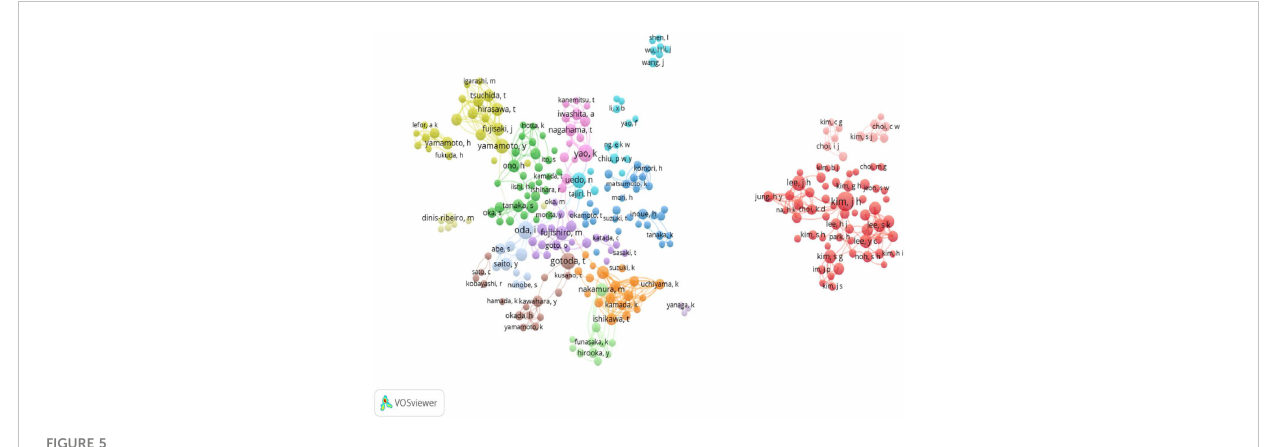
FIGURE 5 Network map of authors in endoscope on EGC